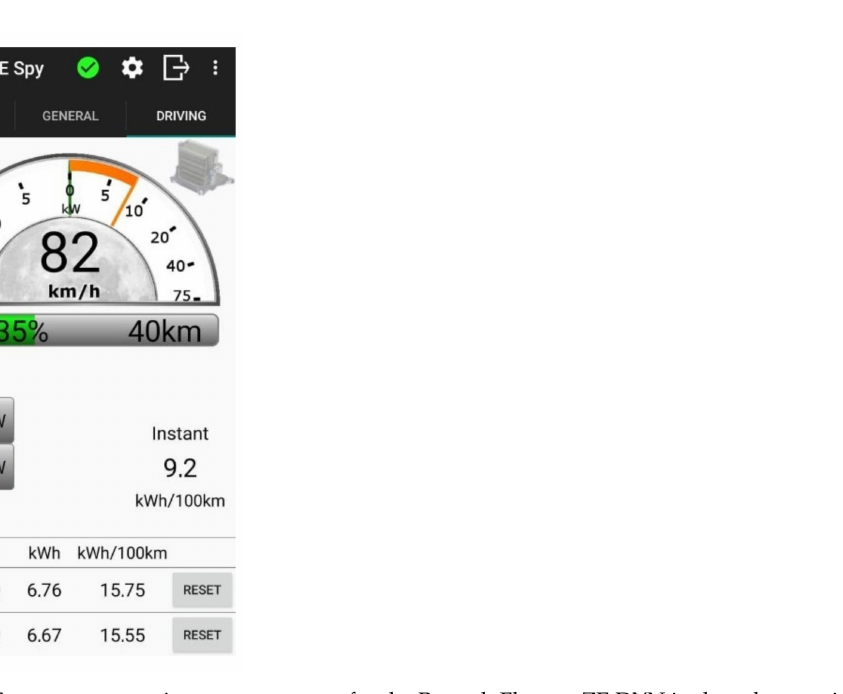
Figure 5. Energy consumption measurements for the Renault Fluence ZE DYN in the urban environ- ment during the driving